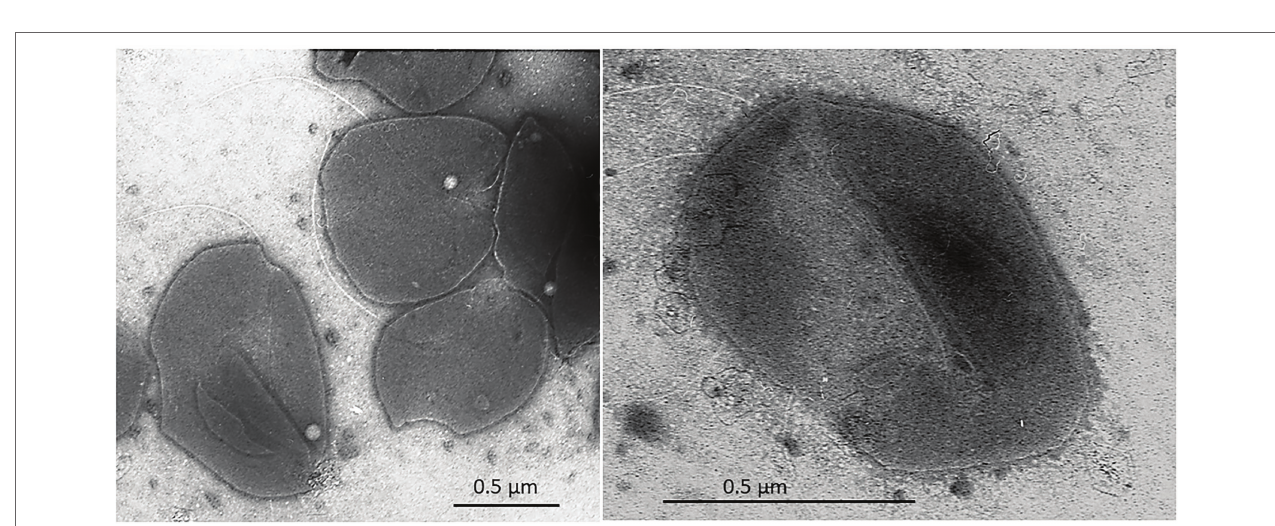
FIGURE 2 | Transmission electron micrograph (TEM) of negatively stained cells of Archaeoglobus neptunius SE56 T sp. nov. shows an overall cell morphology. Bar, 0.5 μ